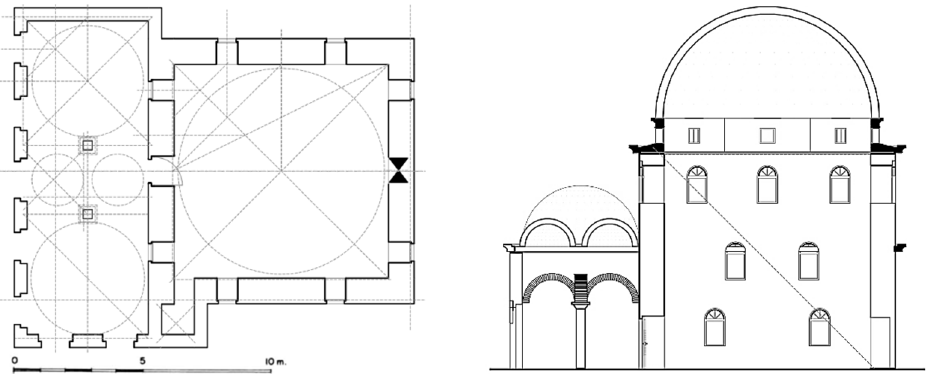
Figure 5. Plan layout ( left ) and section ( right ) of the Lead Mosque in Berat. Provision courtesy from Arch. Arsim Murseli, UBT University, Pristina, Kosovo.